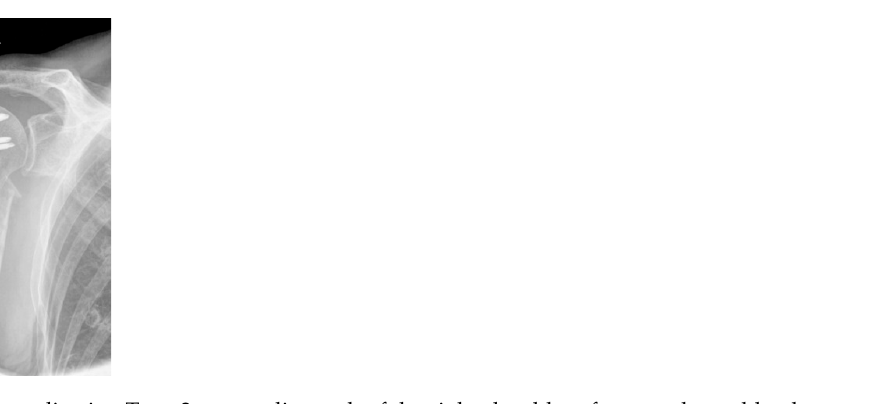
10 of 27 Figure 14. Complication Type 2c. Measurement of varus displacement on an a.p. radiograph of a left shoulder after angular stable plate osteosynthesis with same-sided complication. The cranial screws penetrate the cortical bone. Varus displacement is 27° relative to the anatomic CCD angle of 135°. Figure 15. Complication Type 2c. Pa tt ern image. Severe varus displacement and instability of the humeral head after angle-stable plate osteosynthesis is shown by the transition of the dashed draw- ing (initially correct humeral head position) to the prominent black drawing. This is followed by a